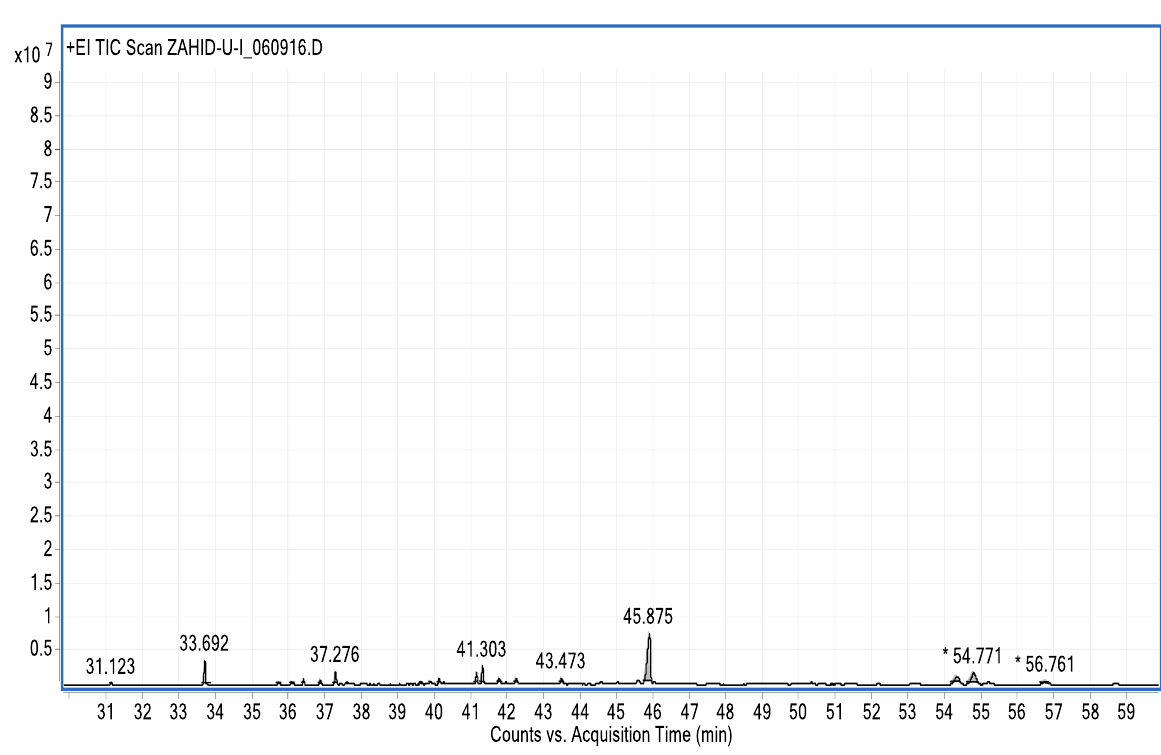
Figure 1. GC–MS chromatogram showing peaks in the range of 31–59, * denoted high values.